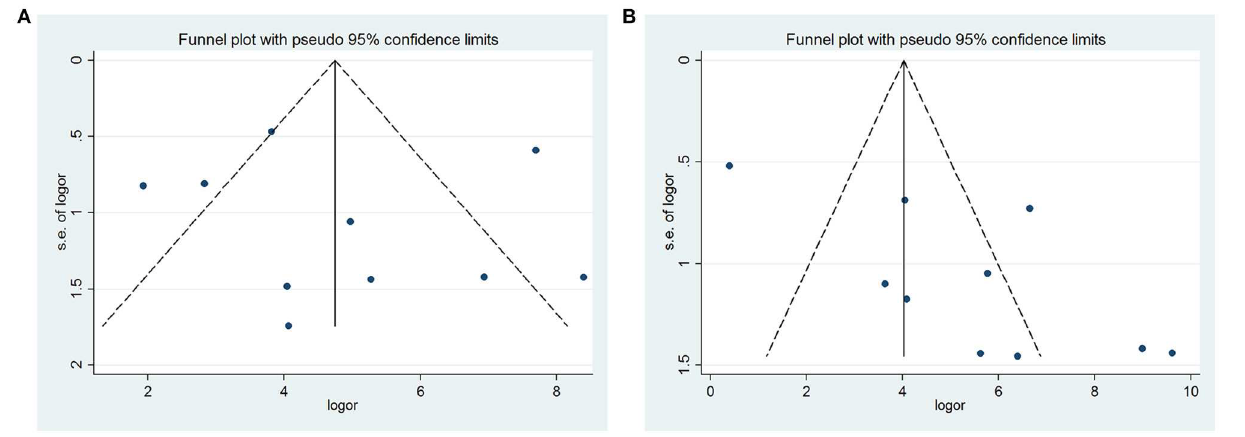
FIGURE 6 | Funnel plot for publication bias test. Each point represents a separate study for the indicated association. (A) FNA; (B)